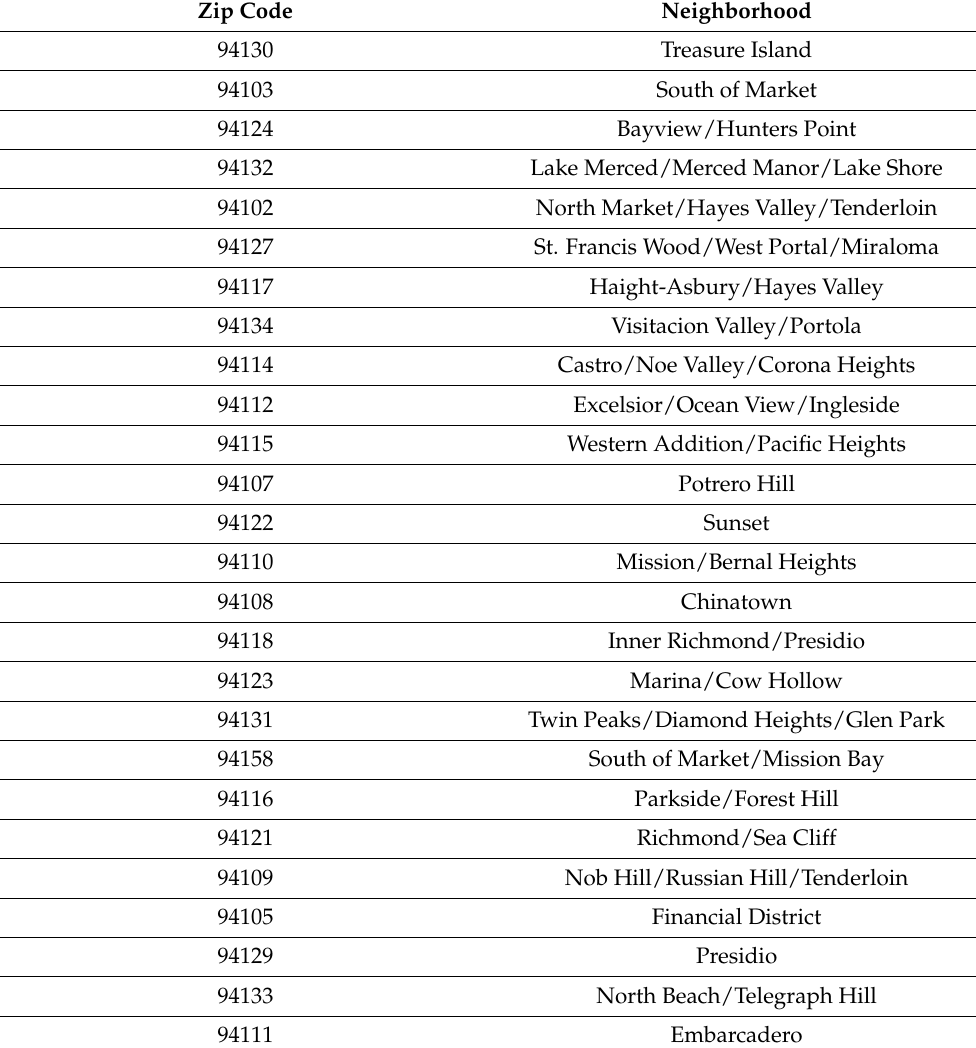
Table 1. SF neighborhoods and their zip code referenced.